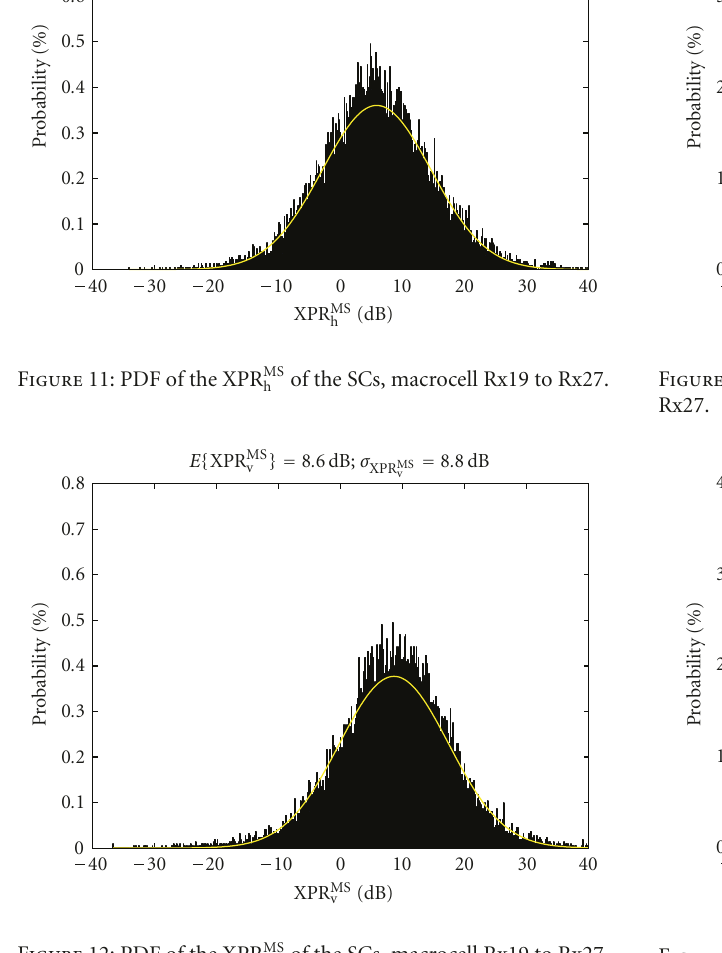
of the DMCs, macrocell Rx19 to v